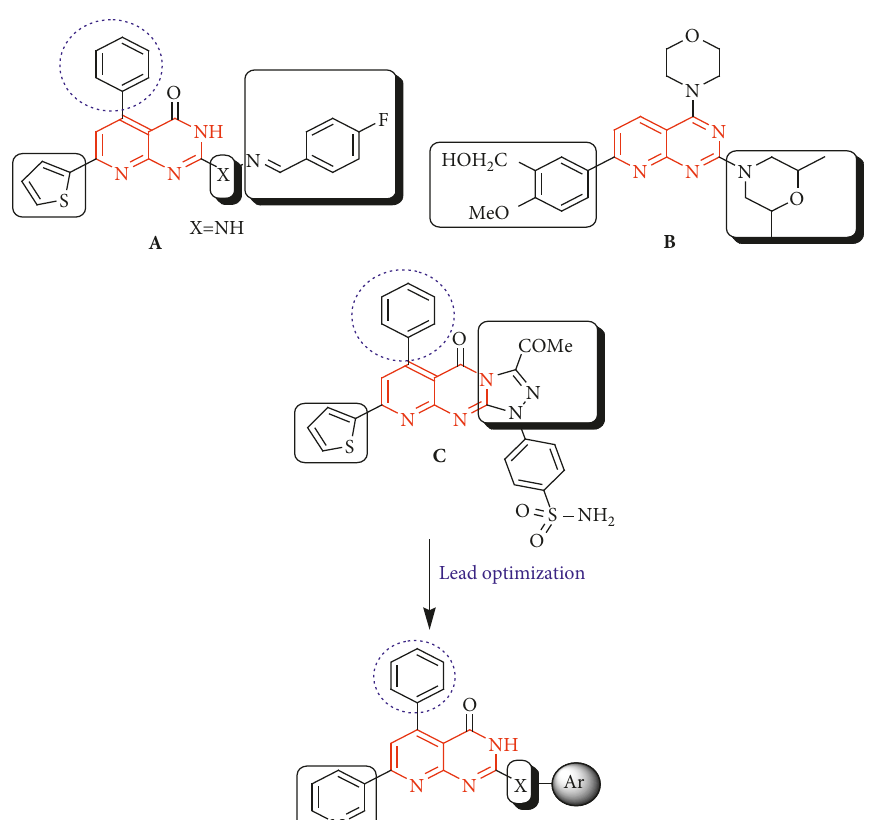
Figure 1: Reported and suggested pyridopyrimidines integrated with kinase inhibitors and anticancer